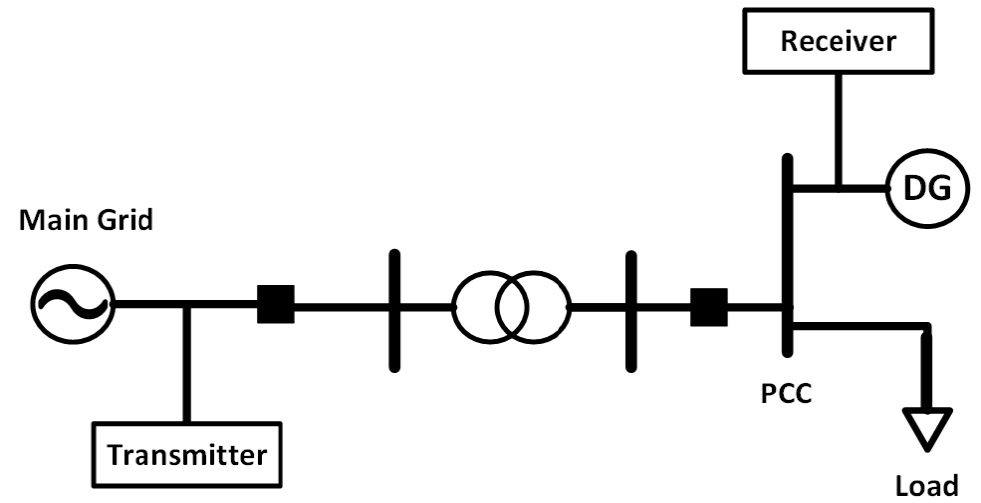
Figure 2. Remote islanding detection scenario.